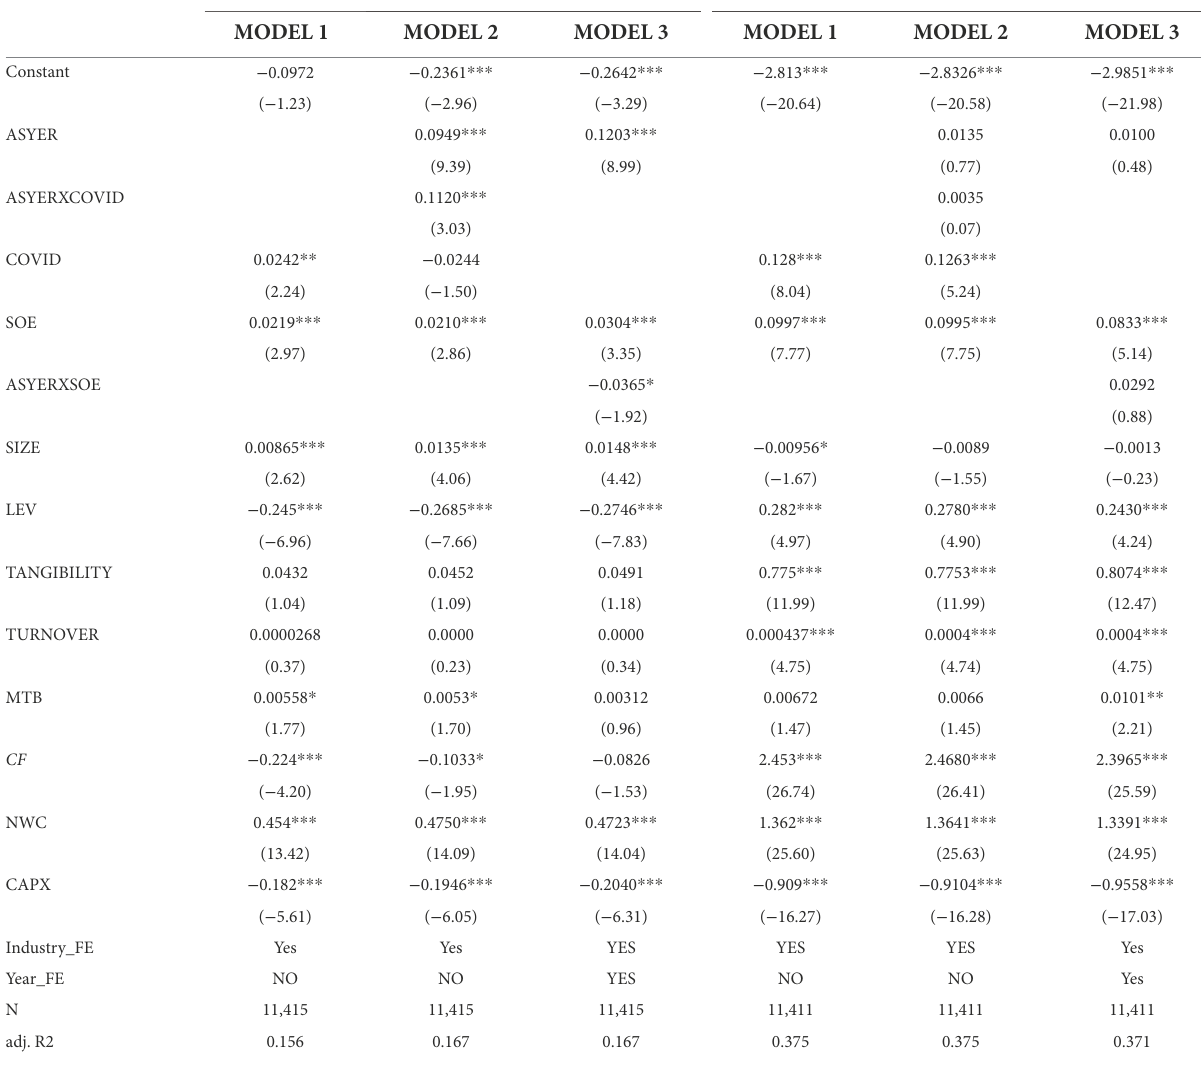
TABLE 9 Robustness checks with alternative measures of dependent